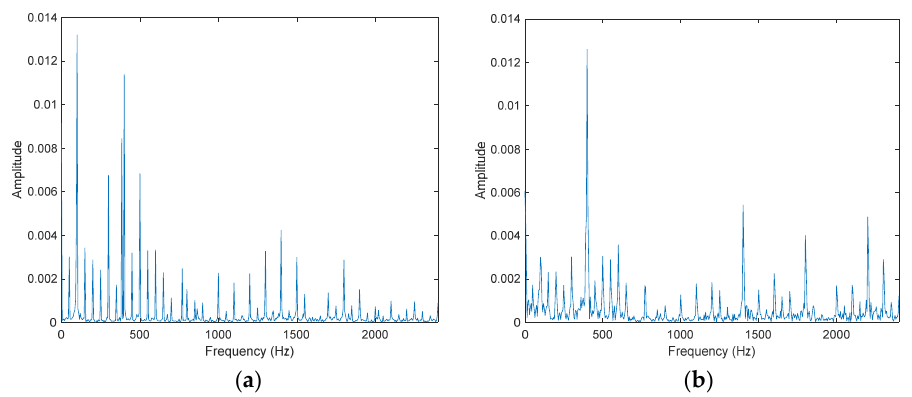
Figure 3. Vibration amplitude and frequency characteristic curves: ( a ) Transformer harmonic oper ‐ ating conditions; ( b ) Transformer three ‐ phase unbalanced operating conditions. ing conditions; ( b ) Transformer three-phase unbalanced operating